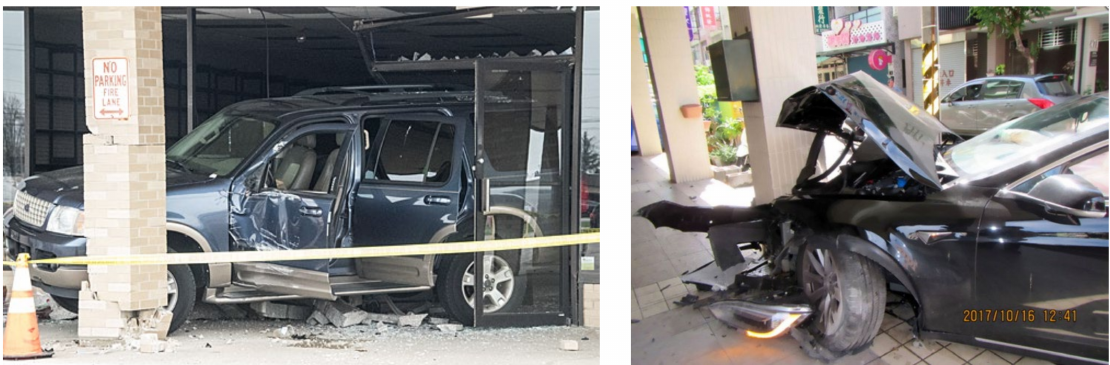
Figure 1. Cars crashed into RC columns on the ground floor